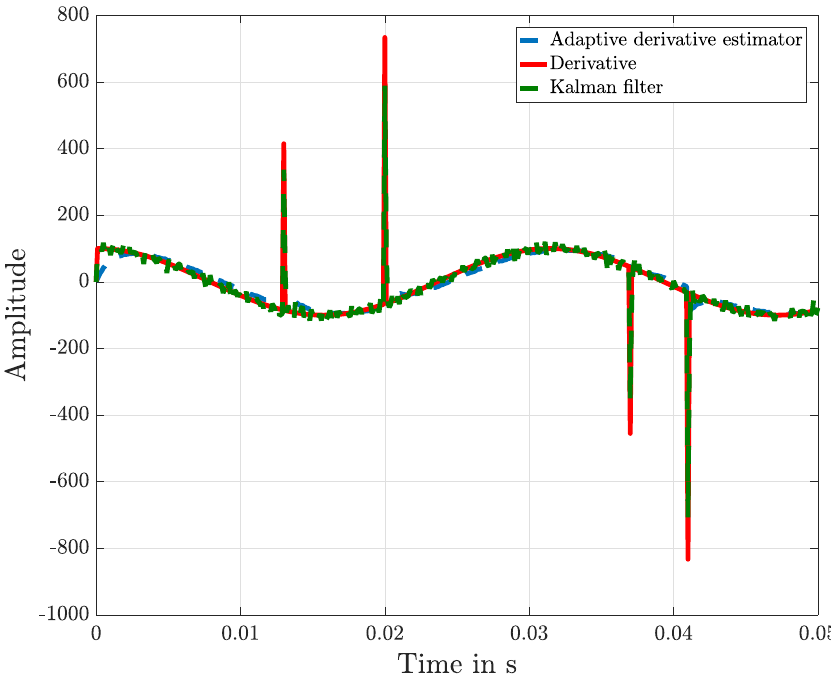
Figure 8. Graphical representation of the resulting velocity from Figure 7 and its estimations with noise and faults.